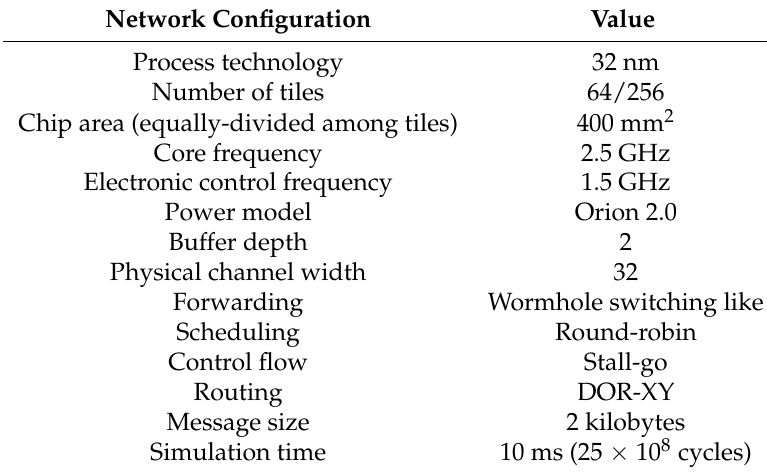
Table 2. Hardware configuration parameters. DOR, Dimension-Ordered Routing.